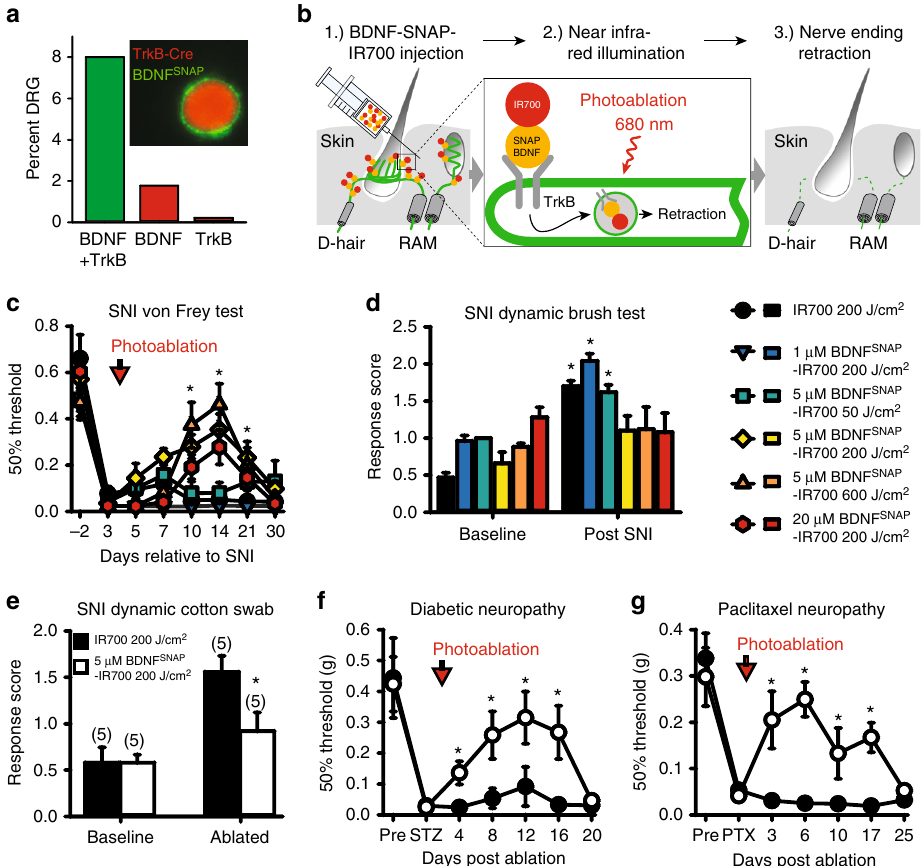
Fig. 5 Optopharmacological targeting of TrkB + neurons with BDNF SNAP . a Labeling (inset) and quanti fi cation of dissociated DRG from TrkB CreERT2 :: Rosa26 RFP mice with BDNF SNAP shows substantial overlap of BDNF SNAP binding to TrkB + cells ( n = 4, 450 cells). b Schematic representation of BDNF SNAP -IR700 injection and photoablation. c BDNF SNAP -IR700-mediated photoablation of the paw of SNI mice results in a dose-dependent reversal of mechanical hypersensitivity as assayed with von Frey fi laments ( n = 10, two-way RM ANOVA; p = 0.003 followed by a Bonferroni post hoc test) and d dynamic brush stimuli ( t -test; p = 0.016). e Hypersensitivity to cotton swab is also reversed by photoablation ( t -test: p = 0.042). f BDNF SNAP -IR700- mediated photoablation reverses mechanical allodynia in the streptozotocin (STZ) model of diabetic neuropathy ( n = 5, two-way RM ANOVA; p = 0.007 followed by a Bonferroni post hoc test. Open circles; 5 µ M BDNF SNAP -IR700 at 200 J/cm 2 , closed circles, 5 µ M IR700 at 200 J/cm 2 ). g BDNF SNAP -IR700- mediated photoablation reverses mechanical allodynia in the paclitaxel (PTX) model of chemotherapy-induced neuropathy ( n = 5, two-way RM ANOVA; p = 0.027 followed by a Bonferroni post hoc test. Open circles; 5 µ M BDNF SNAP -IR700 at 200 J/cm 2 , closed circles, 5 µ M IR700 at 200 J/cm 2 ). Error